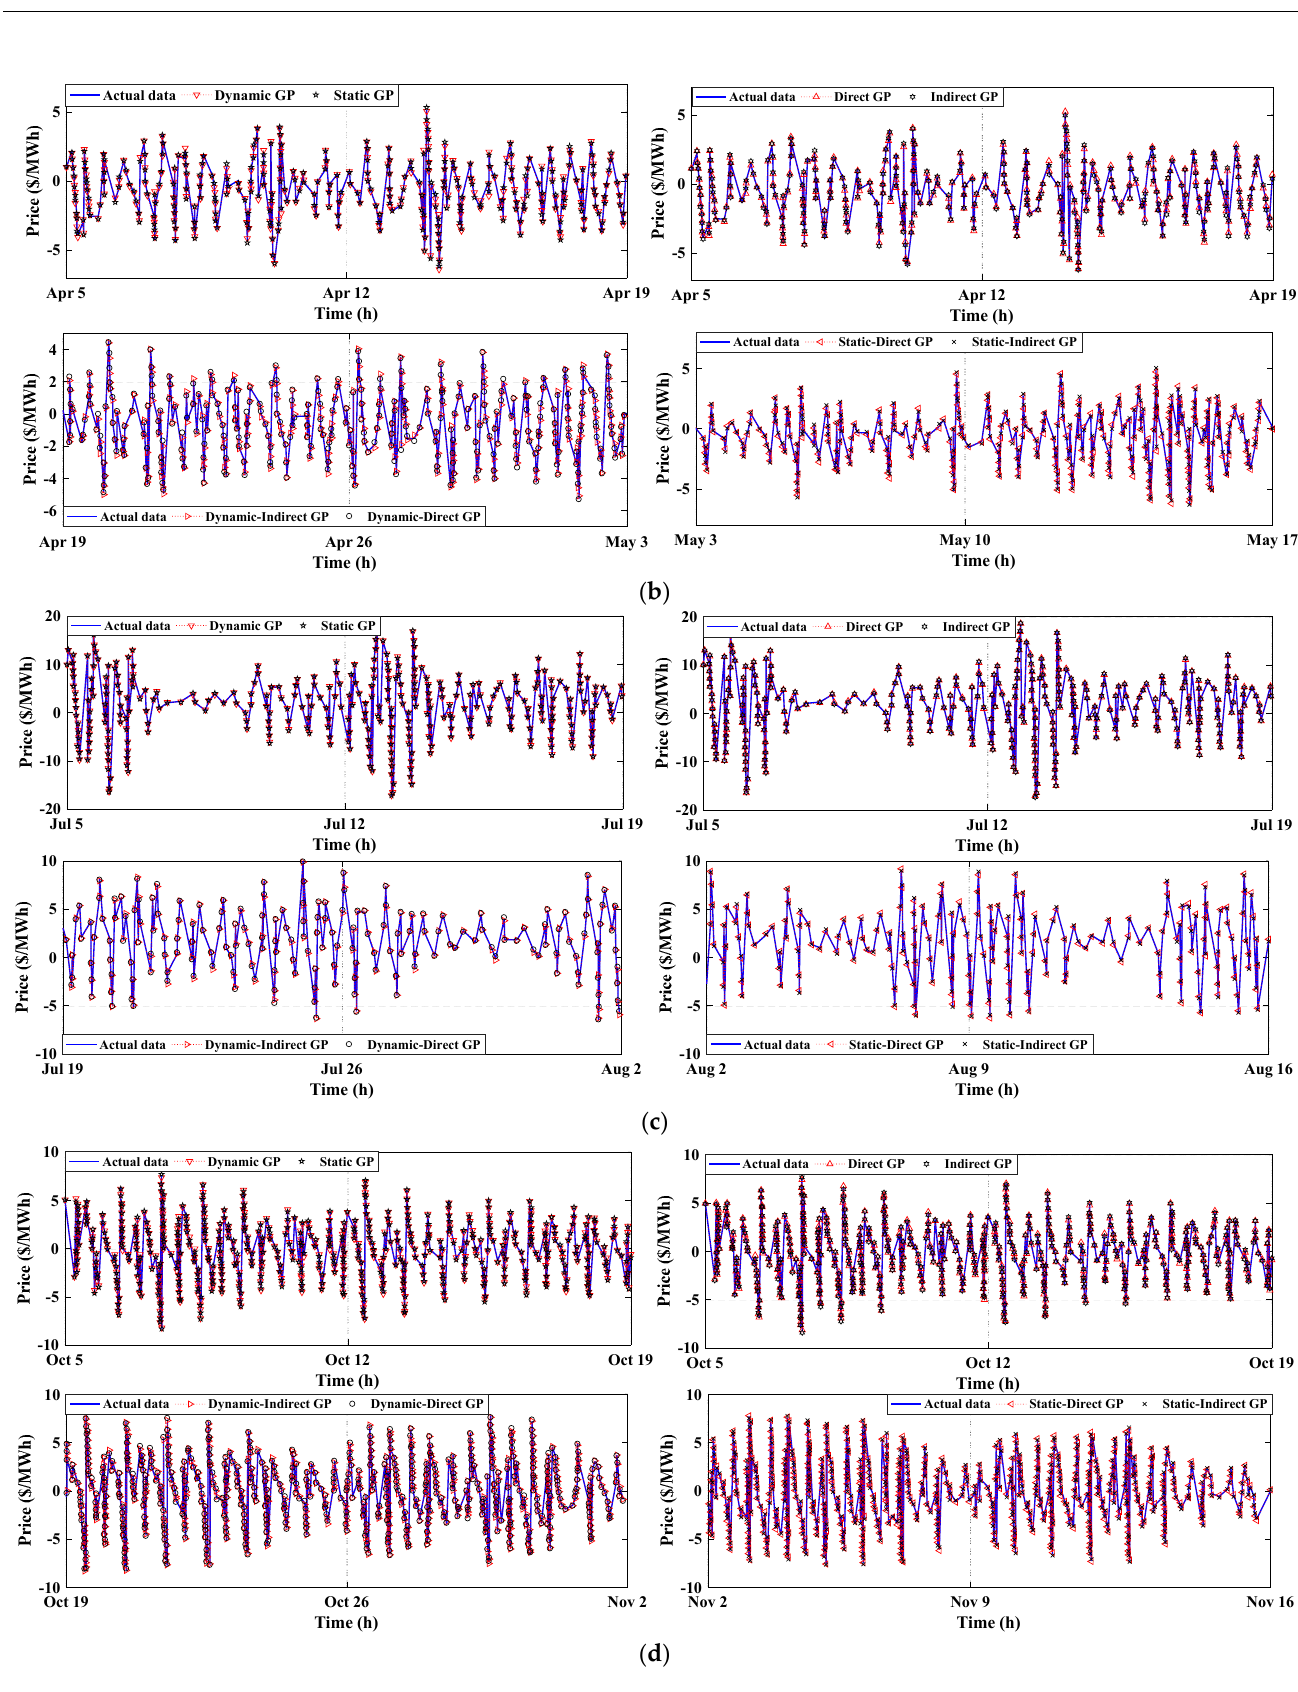
Figure 8. The forecasting of the sum of harmonic components of training data of EP using various models for the electricity market of the US: ( a ) winter, ( b ) spring, ( c ) summer, ( d ) autumn.